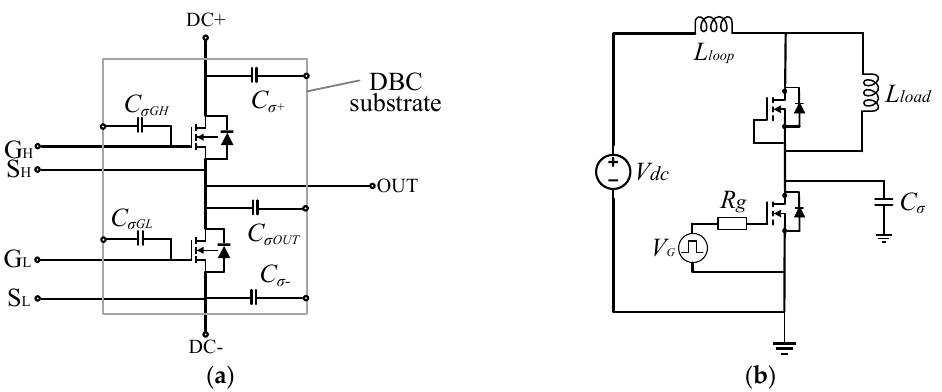
Figure 4. Stray capacitance of SiC half-bridge module ( a ) and double-pulse test simulation in LTSpice ( b ).